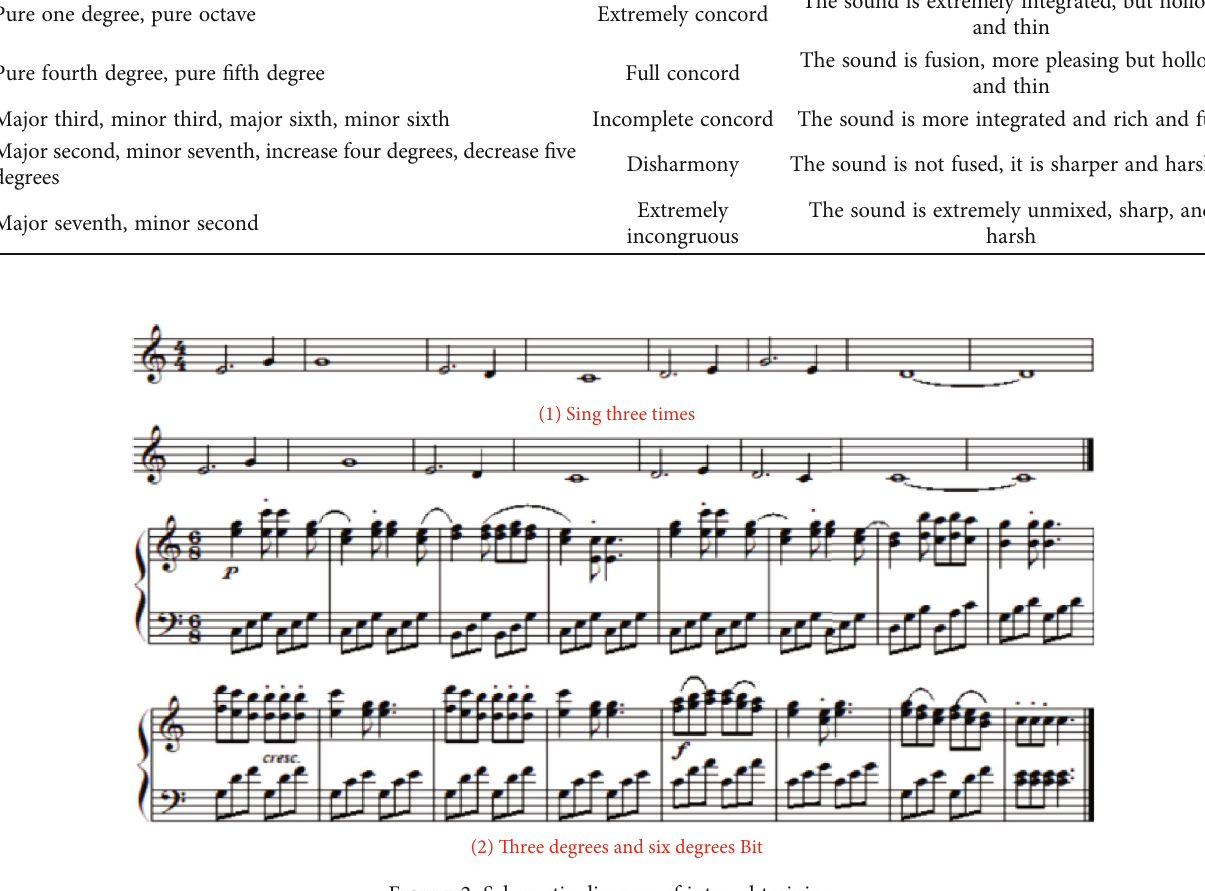
Figure 2: Schematic diagram of interval training.